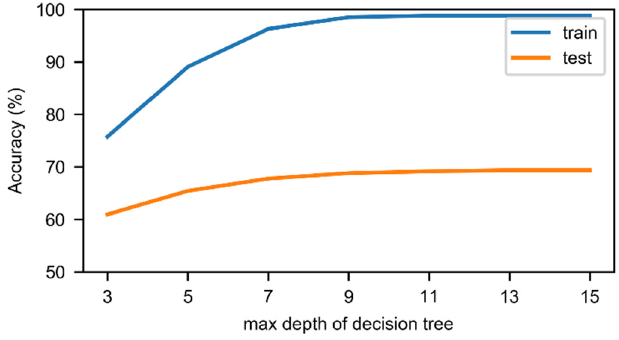
Figure A4. E ff ect of max depth of decision trees on the accuracy of XGBoost in the proposed method.